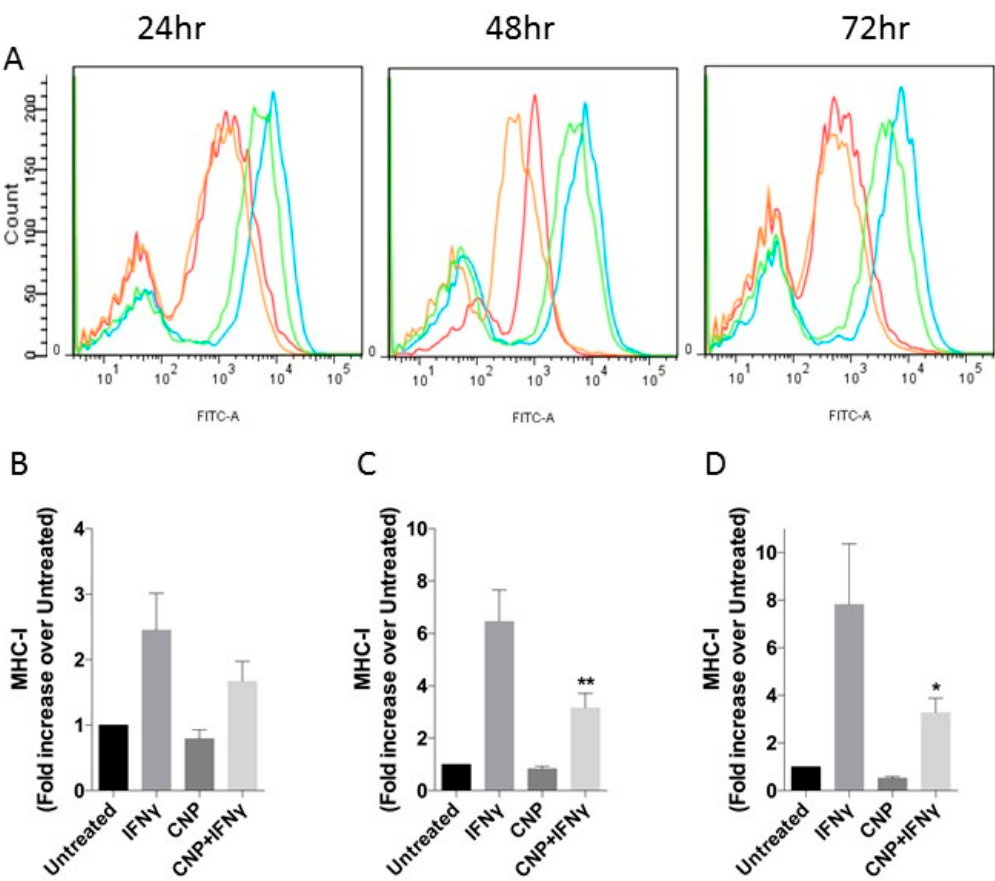
Figure 2. MHC class I expression in HUVEC after incubation with IFN- γ alone or in combinations with CNP for up to 72 h. ( A ) Representative flow cytometry histograms for MHC-I after incubation of HUVEC alone ( Red ) or with IFN- γ ( Blue ), CNP ( Orange ) or IFN- γ and CNP ( Green ) for the indicated times. ( B – D ) Mean Fluorescence Intensity (expressed as fold increase over MFI of untreated cells, which ranged from 2079 to 6549; mean ± SEM) for MHC-I on untreated HUVEC or after 24 h ( B ), 48 h ( C ) or 72 h ( D ) treatment with IFN- γ alone or in combination with CNP; n = 3 HUVEC isolates (* p < 0.05, ** p < 0.01, significantly different from IFN- γ alone).